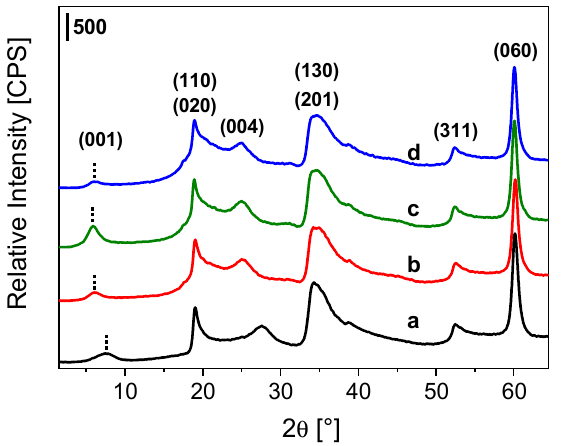
Figure 6. Diffractograms collected in the 1.5-65° 2 θ range of NaSap (a), CTASap (b), CTASapC6AN (c) and CTASapC7AN (d) samples.